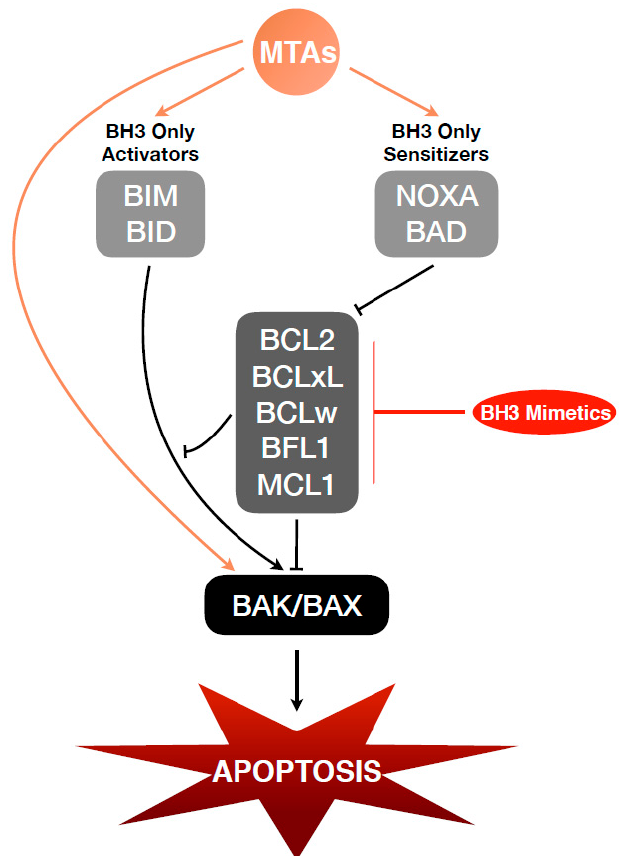
Figure 3. Mechanism of MTAs and BH3 Mimetics on BCL2 Family Signaling. MTAs induce cellular stress that leads to upregulation of pro-apoptotic BCL2 family proteins and ultimately apoptosis. Cancer cells can overcome this through upregulation of anti-apoptotic BCL2 family proteins. BH3 mimetics directly target the anti-apoptotic BCL2 family members to inhibit their suppression of BH3-only activators and / or of BAK / BAX